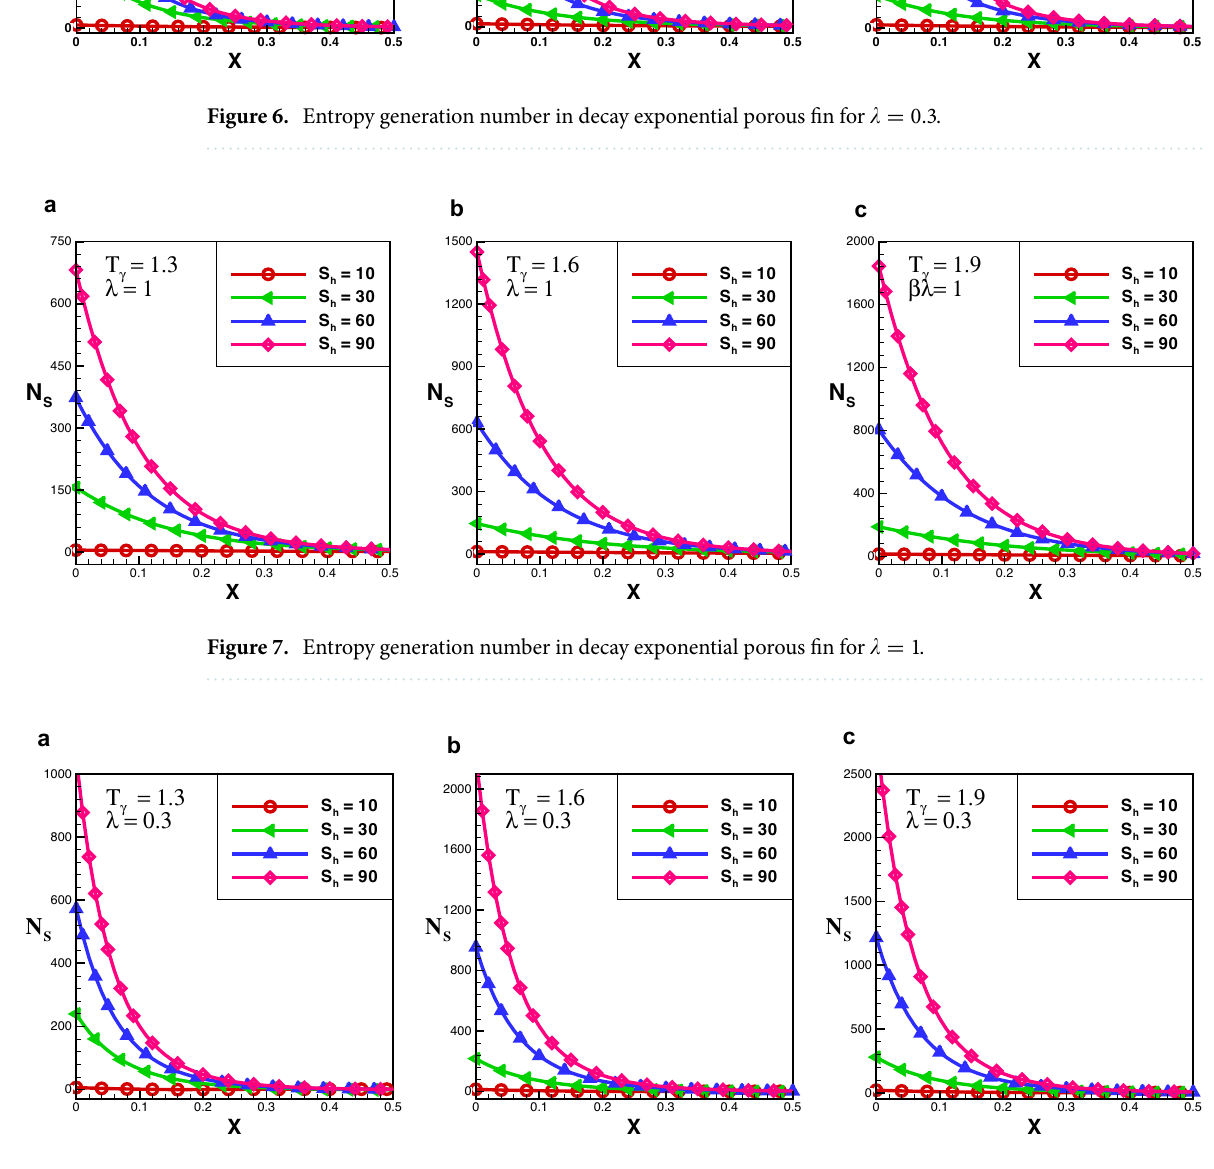
Figure 8. Entropy generation number in growing exponential porous fin for (cid:31) = 0.3